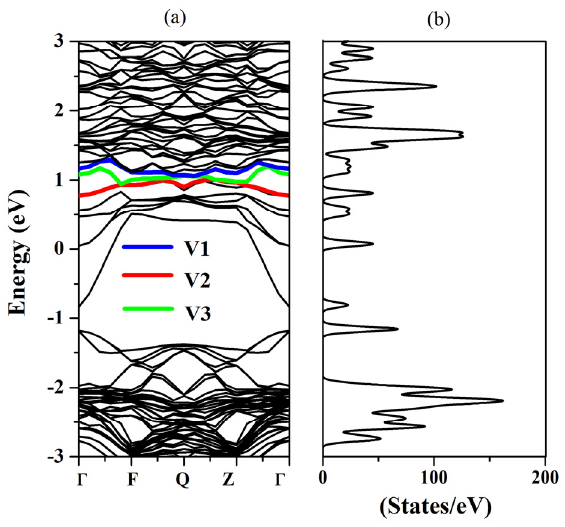
Figure 7. ( a ) The band structures and ( b ) total DOS of Bi Hg -doped Hg 0.75 Cd 0.25 Te.